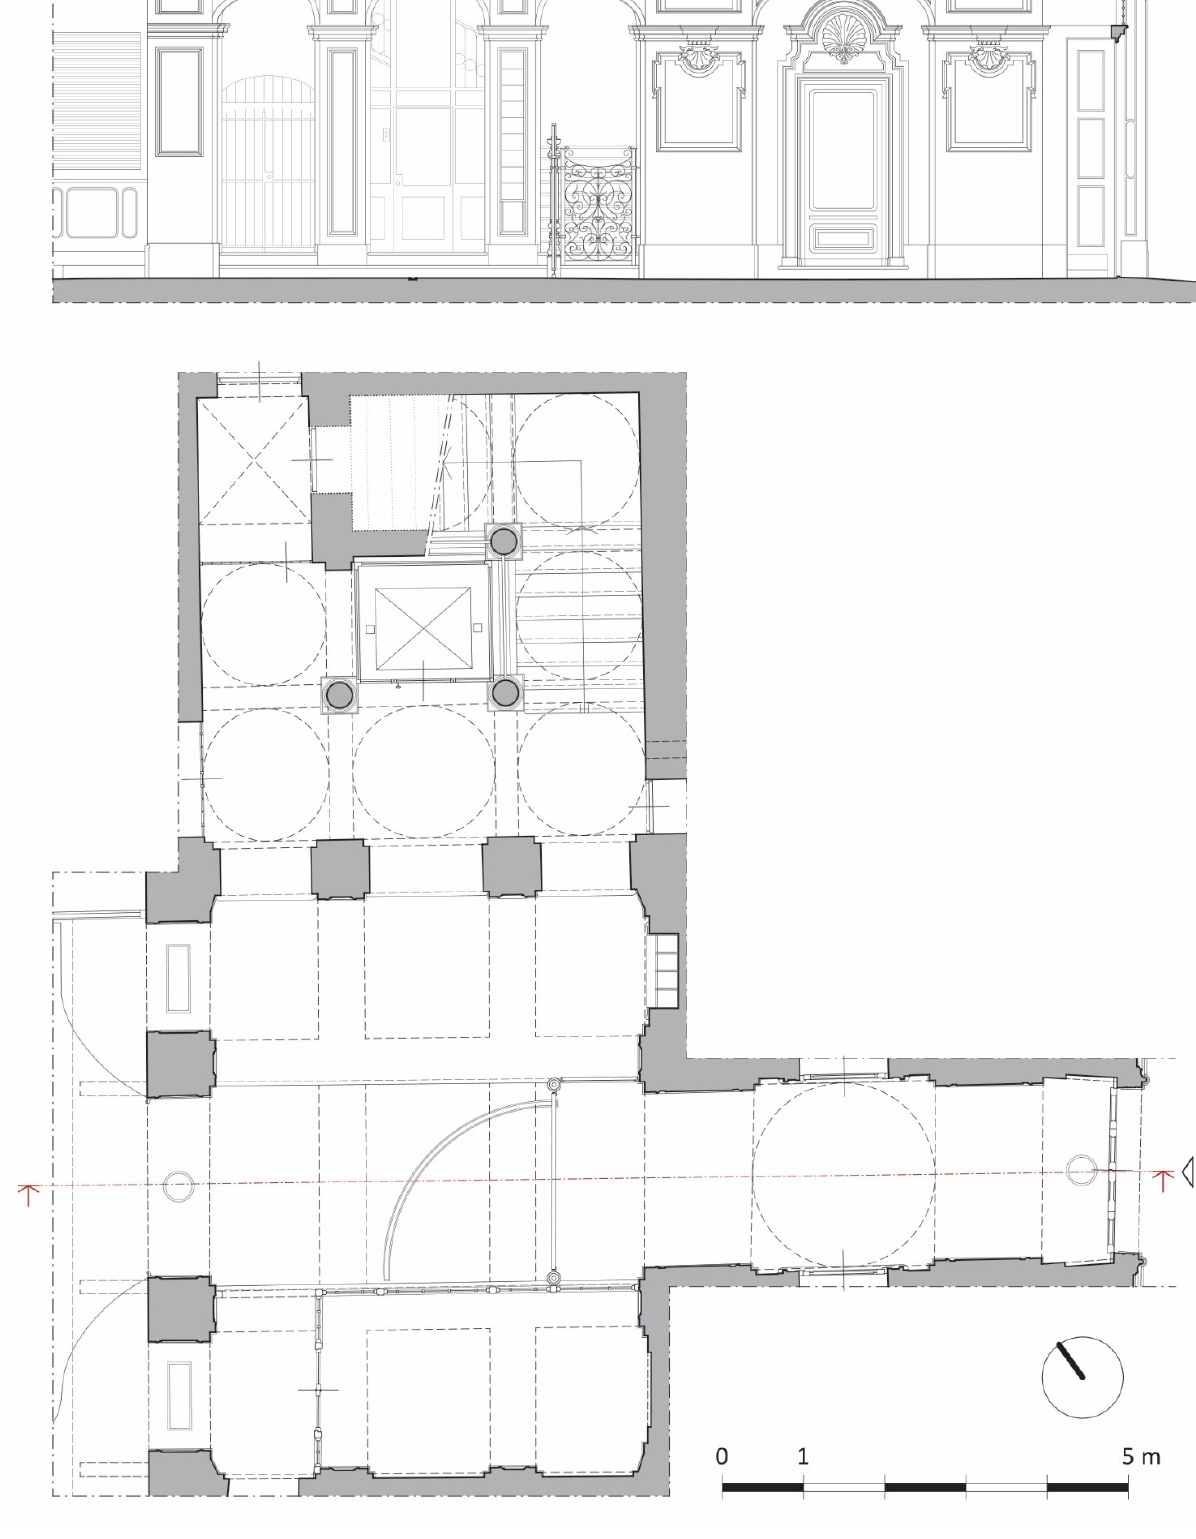
Figure 11. Survey drawings of the atrium in Via dei Mercanti 2. Drawing: F.